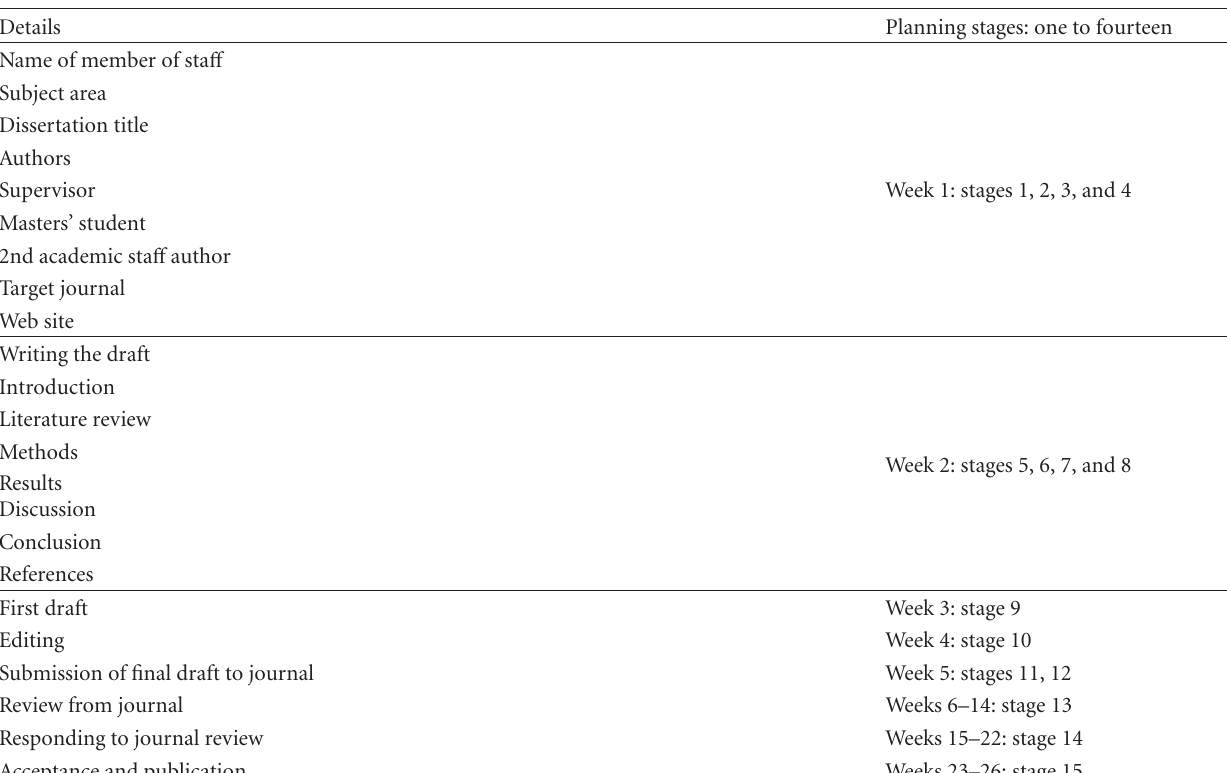
Table 15: Dissertation to journal pro forma (from 2012 to